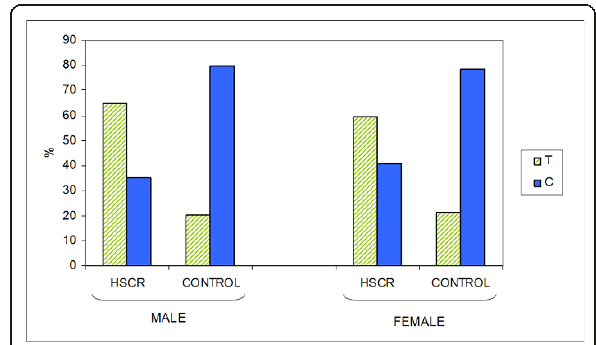
Figure 2 Allelic distribution frequency of RET enhancer variant rs2435357 in Male and Female subset